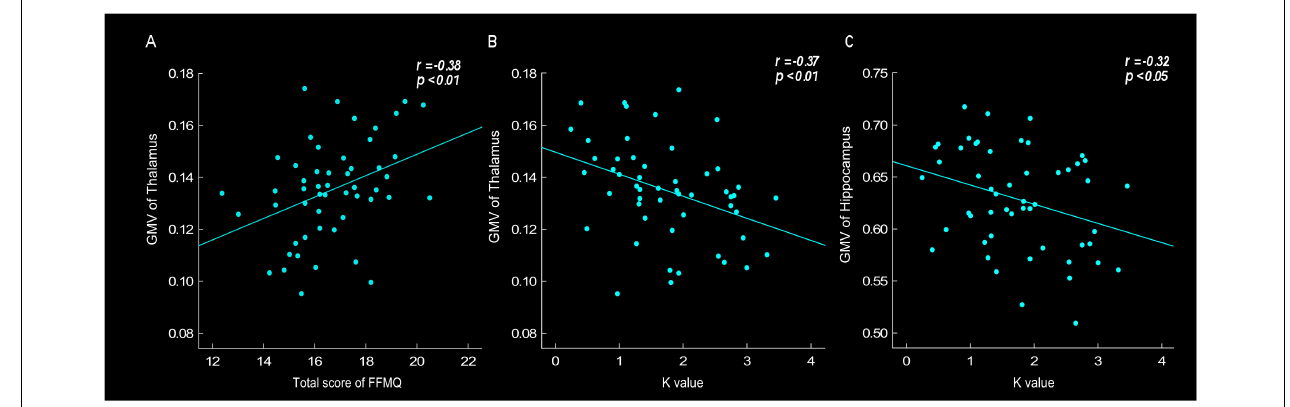
FIGURE 3 | Gray matter volume (GMV) of thalamus was positively correlated with total score of FFMQ ( r = 0.38, p < 0.01) (A) , and negatively correlated with K -value ( r = –0.37, p < 0.01) (B) . GMV of hippocampus was negatively correlated with K -value ( r = –0.32, p < 0.05) (C)